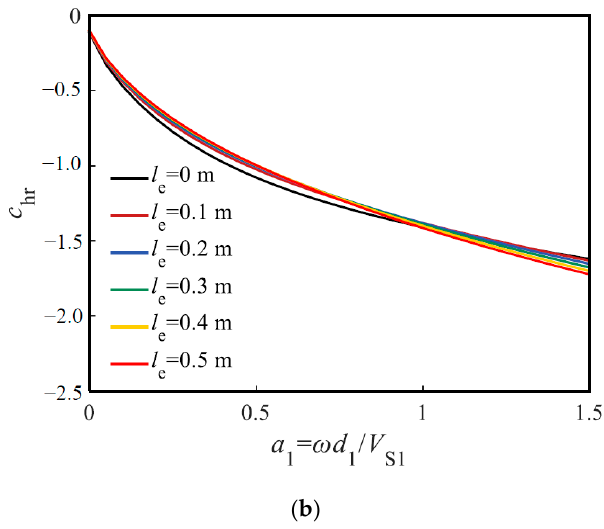
Figure 9. Influence of weak pile segment length on the HRDI of pile head. ( a ) Stiffness factor of HRDI and ( b ) damping factor of HRDI.